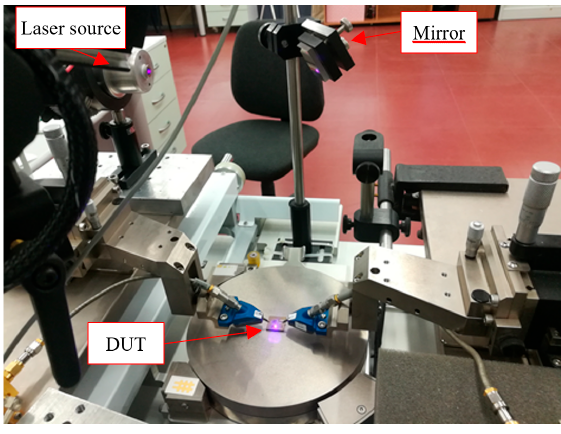
Figure 1. Picture of the optical setup.